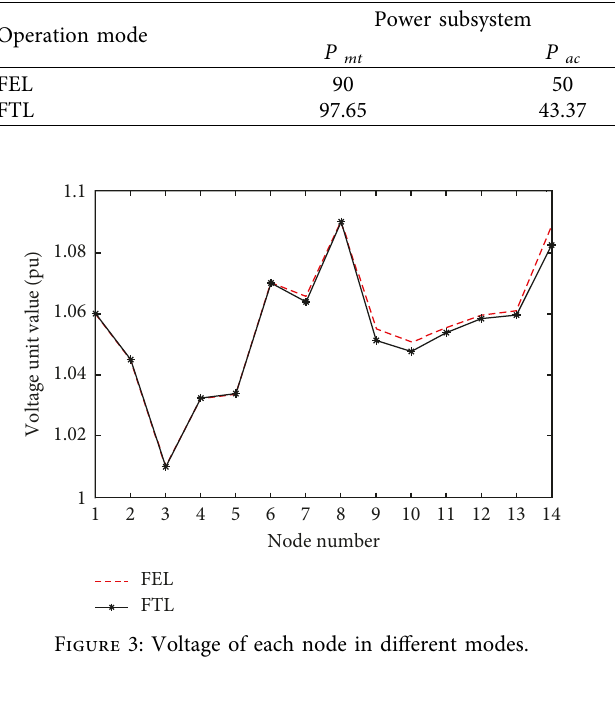
Table 11: Initial solution of power flow in multi-energy systems.